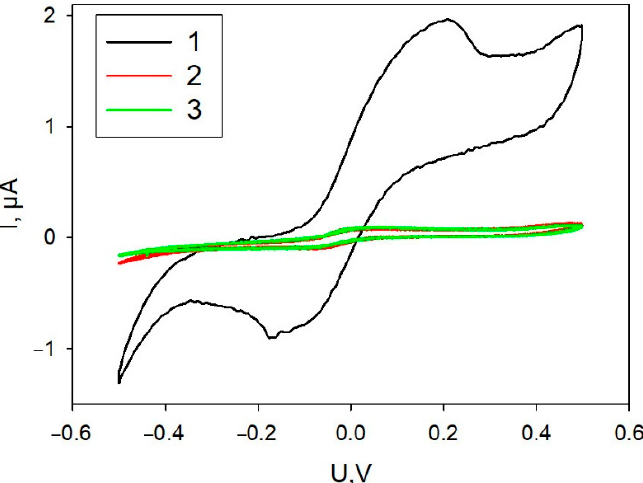
Figure 2. Cyclic voltammograms of a bioelectrode depending on the order of applying the mixture components. 1, Layer-by-layer application of a PEDOT:PSS/graphene mixture, then of a mixture of cells with Nafion; 2, a mixture of PEDOT:PSS/graphene and Nafion, then cells; 3, a mixture of Nafion with cells, then the mixing with PEDOT:PSS/graphene.